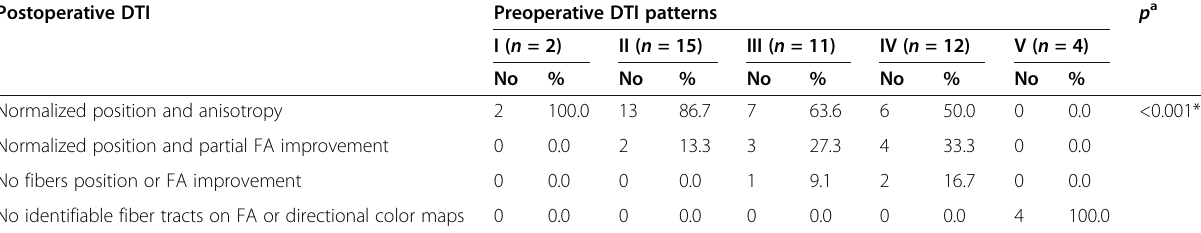
Table 4 Association between preoperative DTI patterns and postoperative DTI findings Postoperative